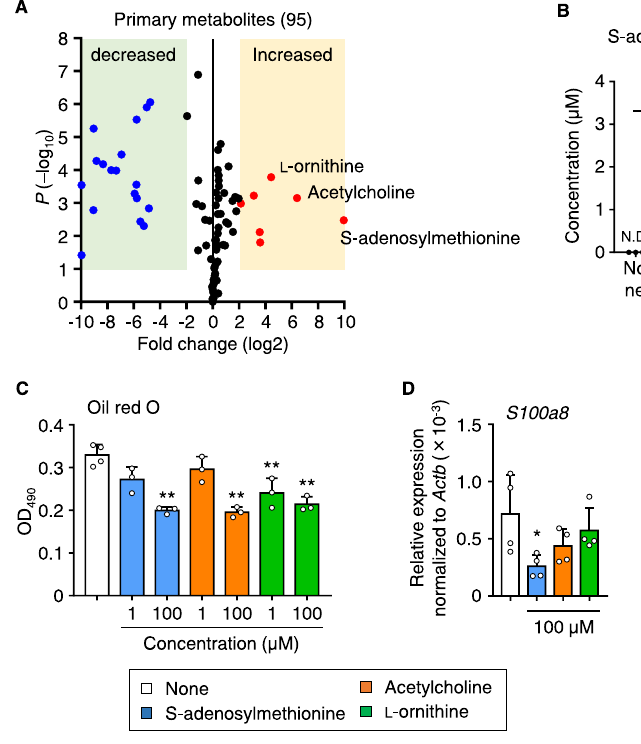
Fig. 4 | Blautia wexlerae showed unique characteristics in amino acid meta- bolism, such as production of S-adenosylmethionine, acetylcholine, and L - ornithine. A Volcano plot showing LC – MS/MS analysis of B. wexlerae culture supernatant. Red and blue dots indicate metabolites increased and decreased, respectively, by more than fourfold in B. wexlerae culture supernatant compared withfreshmedium( n =4biologicallyindependentsamples).Statisticalsigni fi cance was evaluated by using two-tailed unpaired t -test. B Quantitative measurement by LC – MS/MS of S-adenosylmethionine, acetylcholine, and L -ornithine in fresh med- ium (none) and culture supernatants of B. wexlerae (Bw) and major intestinal bacteria including Bacteroides vulgatus (Bv), Prevotella copri (Pc),